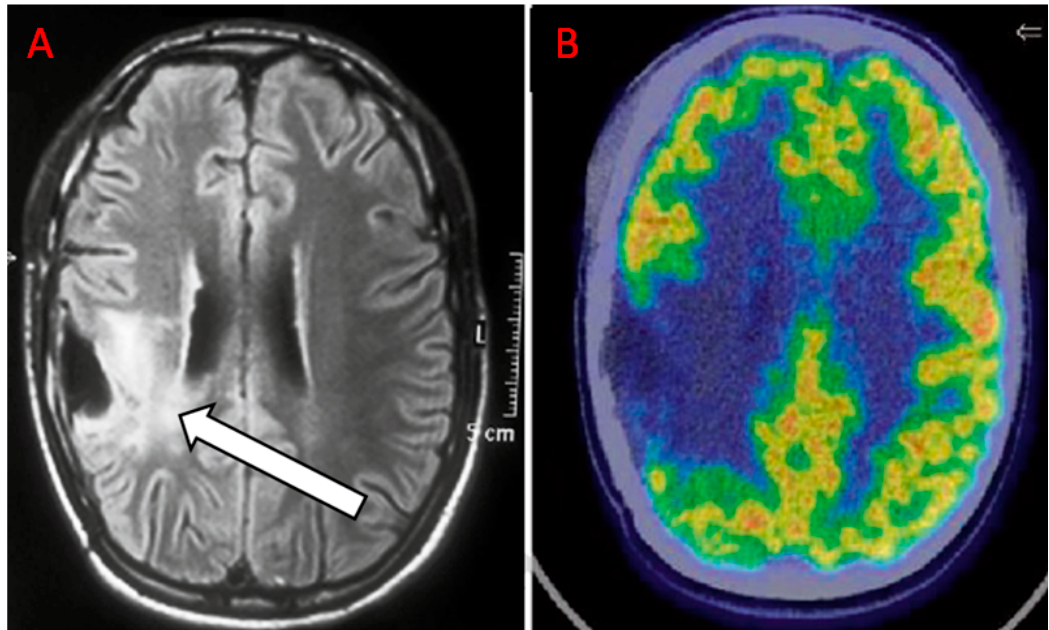
Figure 2. Anaplastic oligoastrocytoma treated with surgery, radiotherapy (RT), and concurrent temozolomide eight months before. ( A ) magnetic resonance imaging (MRI) shows suspicious findings for recurrence (white arrow). ( B ) the 18 F-FDG PET/CT scan document no uptake, which is compatible with radionecrosis (RN) (Courtesy of Dr. Cistaro).